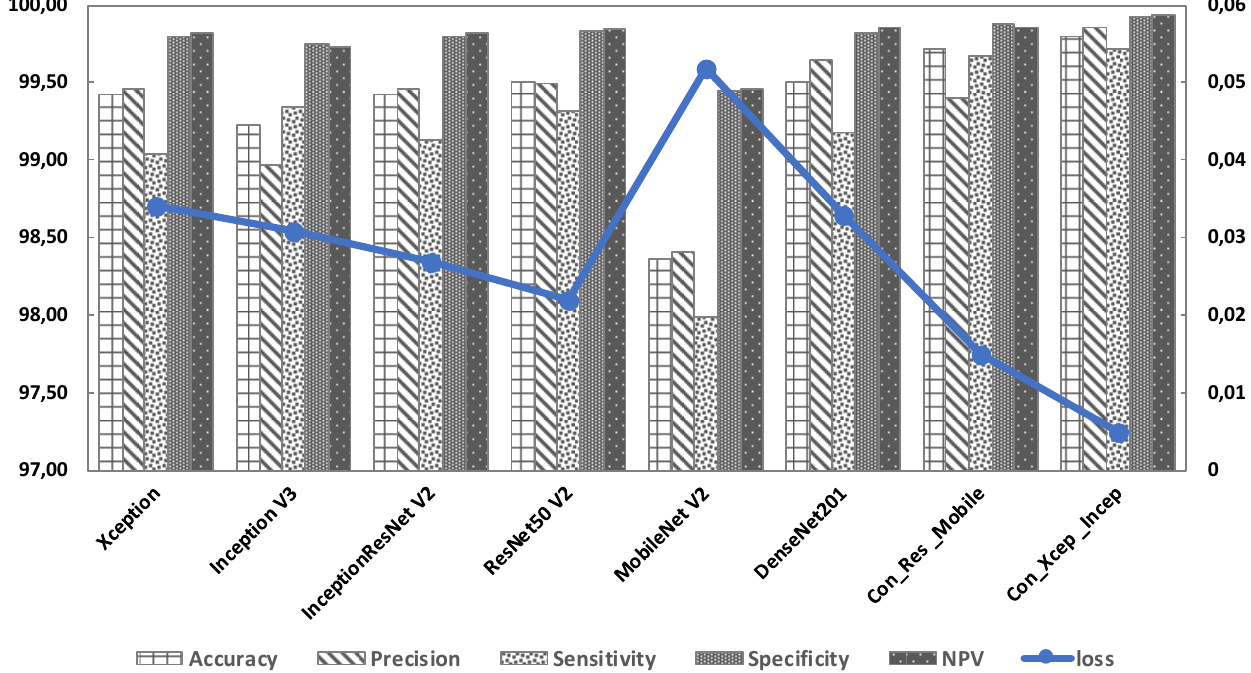
Figure 11. Metrics for Performance Evaluation for all studied models.